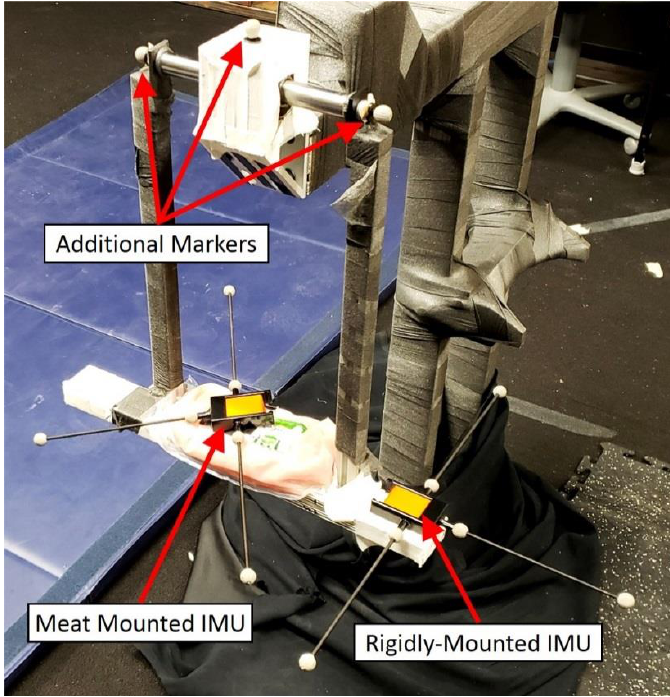
Figure 5. The pendulum as set up for experimentation. The IMUs and markers were placed such that the axis of rotation, IMU location, and IMU orientation could be calculated independently by both the optical and inertial systems.